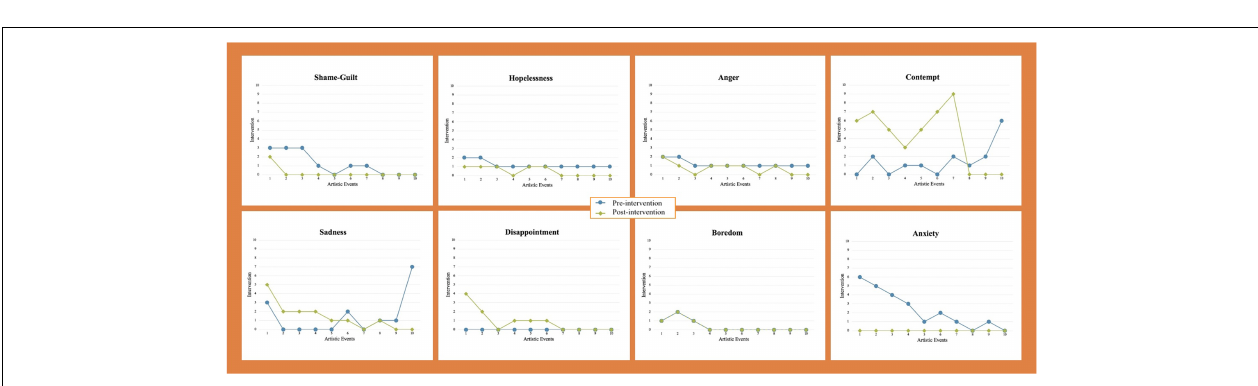
FIGURE 3 | Visual direction for negative emotions. NB: Pre-intervention is represented by a blue line; Post-intervention is represented by a green line.